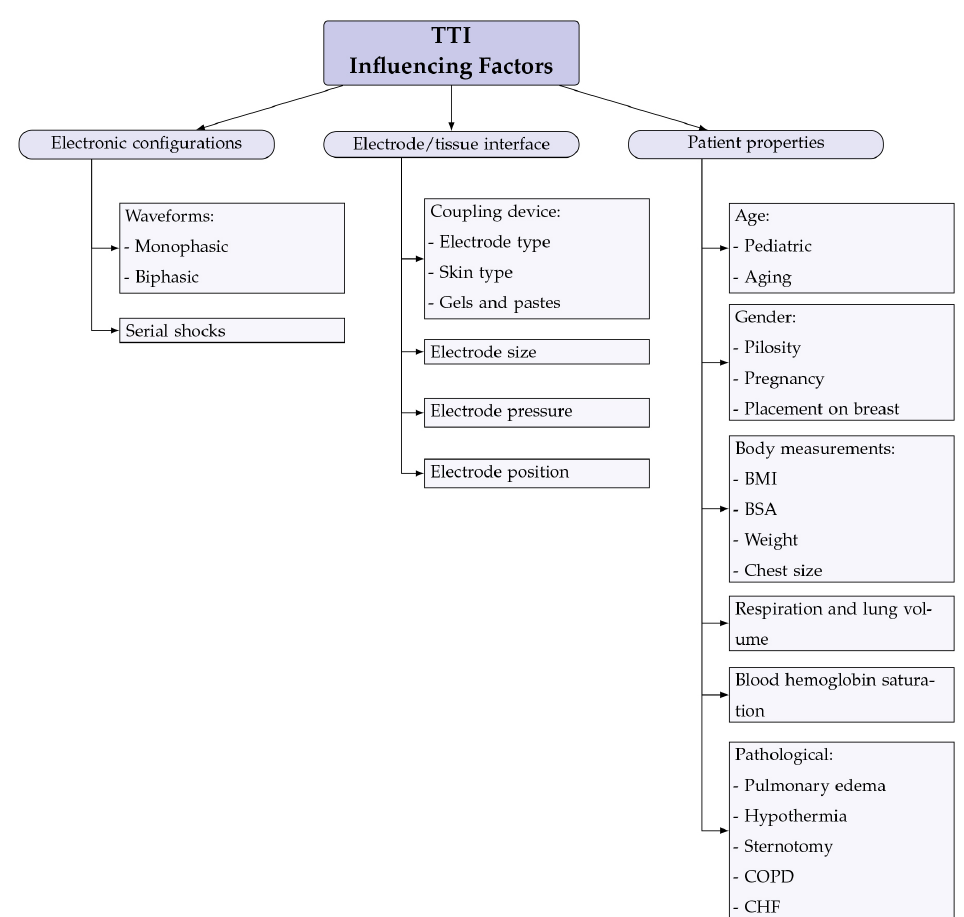
Figure 5. All TTI influencing factors found in the literature review and categorization into the different impedance determining